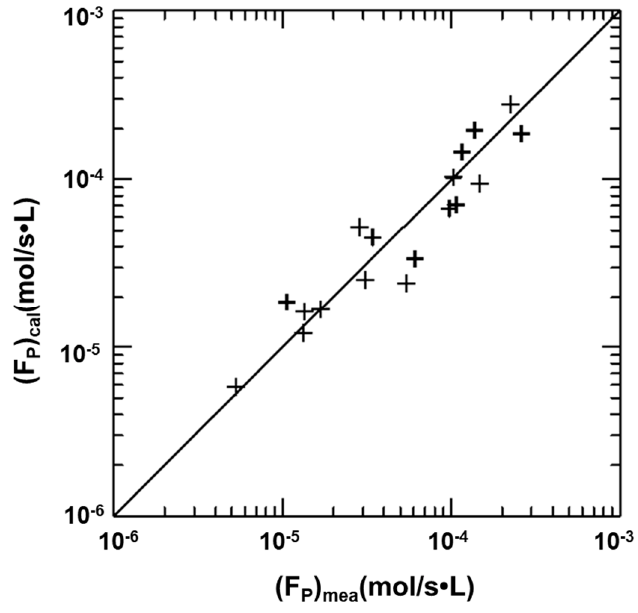
Figure 13. A plot of calculated versus measured ψ showing the confidence of regression.